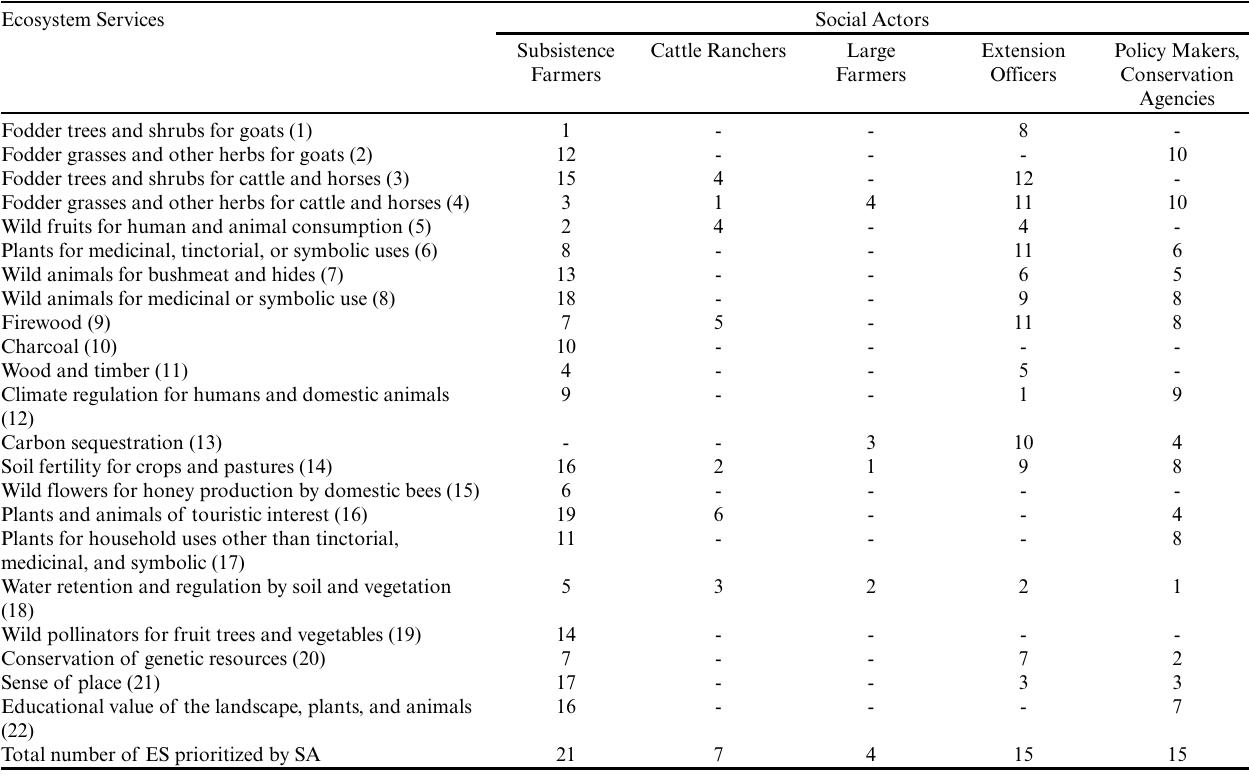
Table 2 . Relative importance of the ecosystem services (ES) offered by six ecosystem types according to the priorities and interests of different social actors (the lower the number the more important is the ES). The importance of the ecosystem services was calculated using the priorities made by attendants of the focus group. The numbers in brackets correspond to those of colored circles in Figure 3. Ecosystem